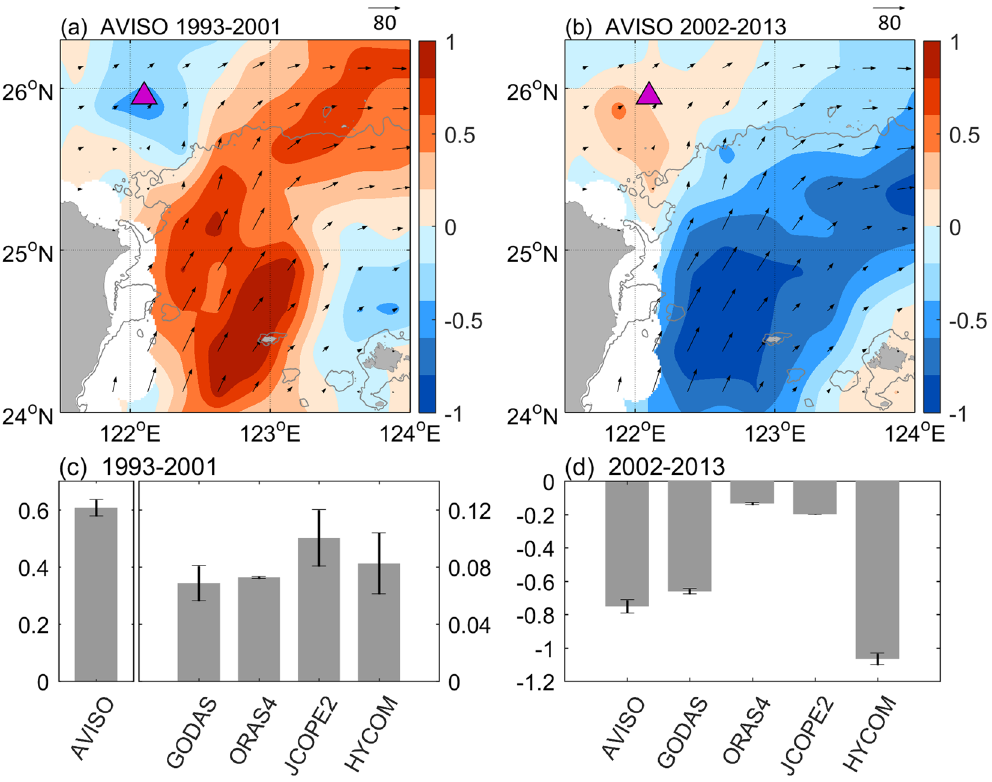
Figure 3. Linear trend of the last IMF of surface velocity off east Taiwan. ( a , b ) Linear trend of the last IMF calculated from AVISO altimeter data during 1993–2001 and 2002–2013, respectively. Trend (shading, in units of cm s − 1 yr − 1 ), mean velocity (vector, in units of cm s − 1 ), 200 m isobath (gray contour) and the KIE region (triangle) are also shown. ( c , d ) The area-averaged linear trend (in units of cm s − 1 yr − 1 ) of the last IMF of the upstream Kuroshio deriving from five independent data sets during 1993–2001 and 2002–2013, respectively. All figures are generated with MATLAB (R2017a;